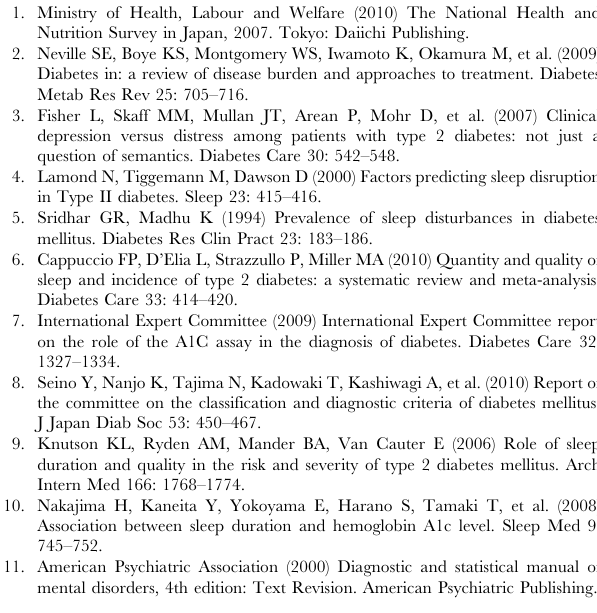
Table S1 Associations between each of 3 types of insomnia symptoms and HbA 1c as a continuous variable. Table S2 Prevalence of 3 types of insomnia symptoms among analyzed participants and excluded diabetes patients. Table S3 Associations between each of 3 types of insomnia symptoms and high HbA 1c when including diabetes patients in the